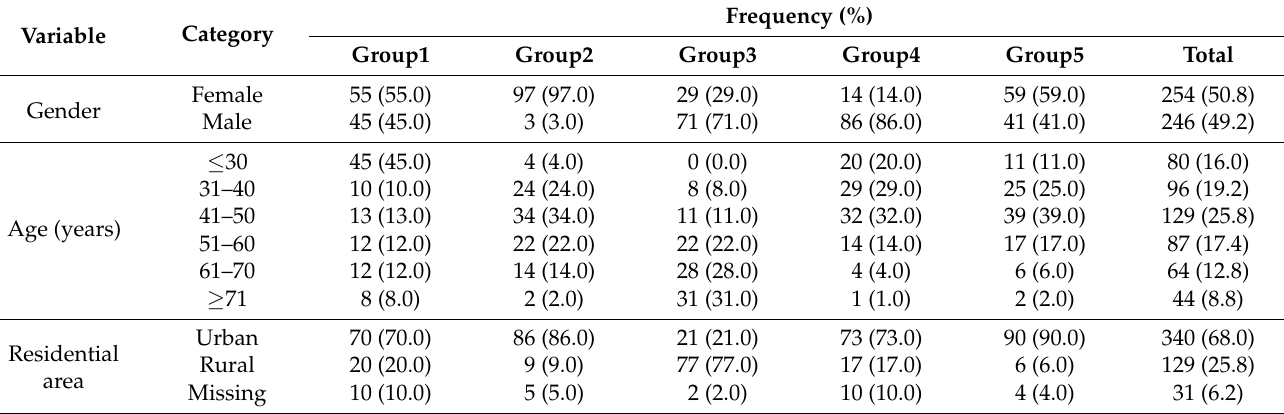
Table 1. Participants’ demographic data.